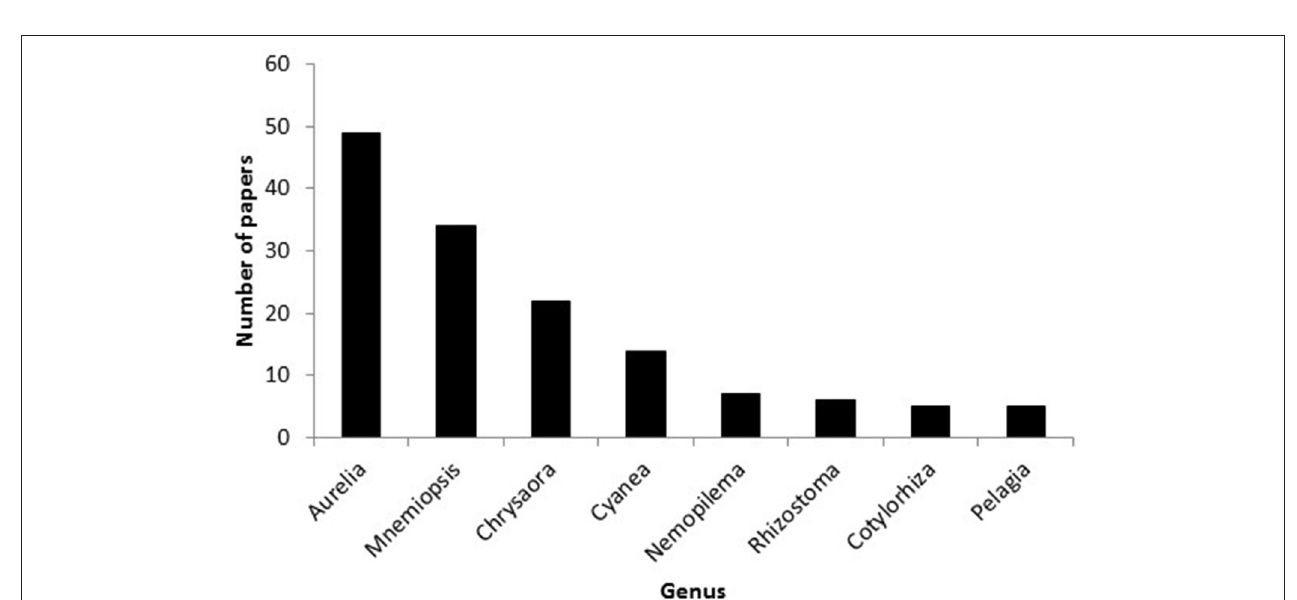
FIGURE 7 | Number of cited papers that featured each